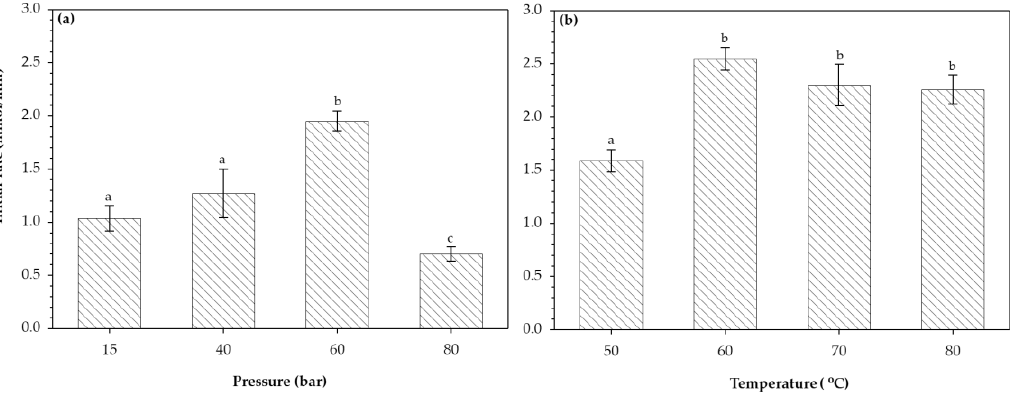
Figure 4. Initial rate of lactose conversion: ( a ) pressure effect (temperature = 60 °C) and ( b ) temperature effect (pressure = 60 bar). Mean ± standard deviation within treatments with different letters are ( a – c ) significantly different ( p < 0.05) according to Tukey’s test.